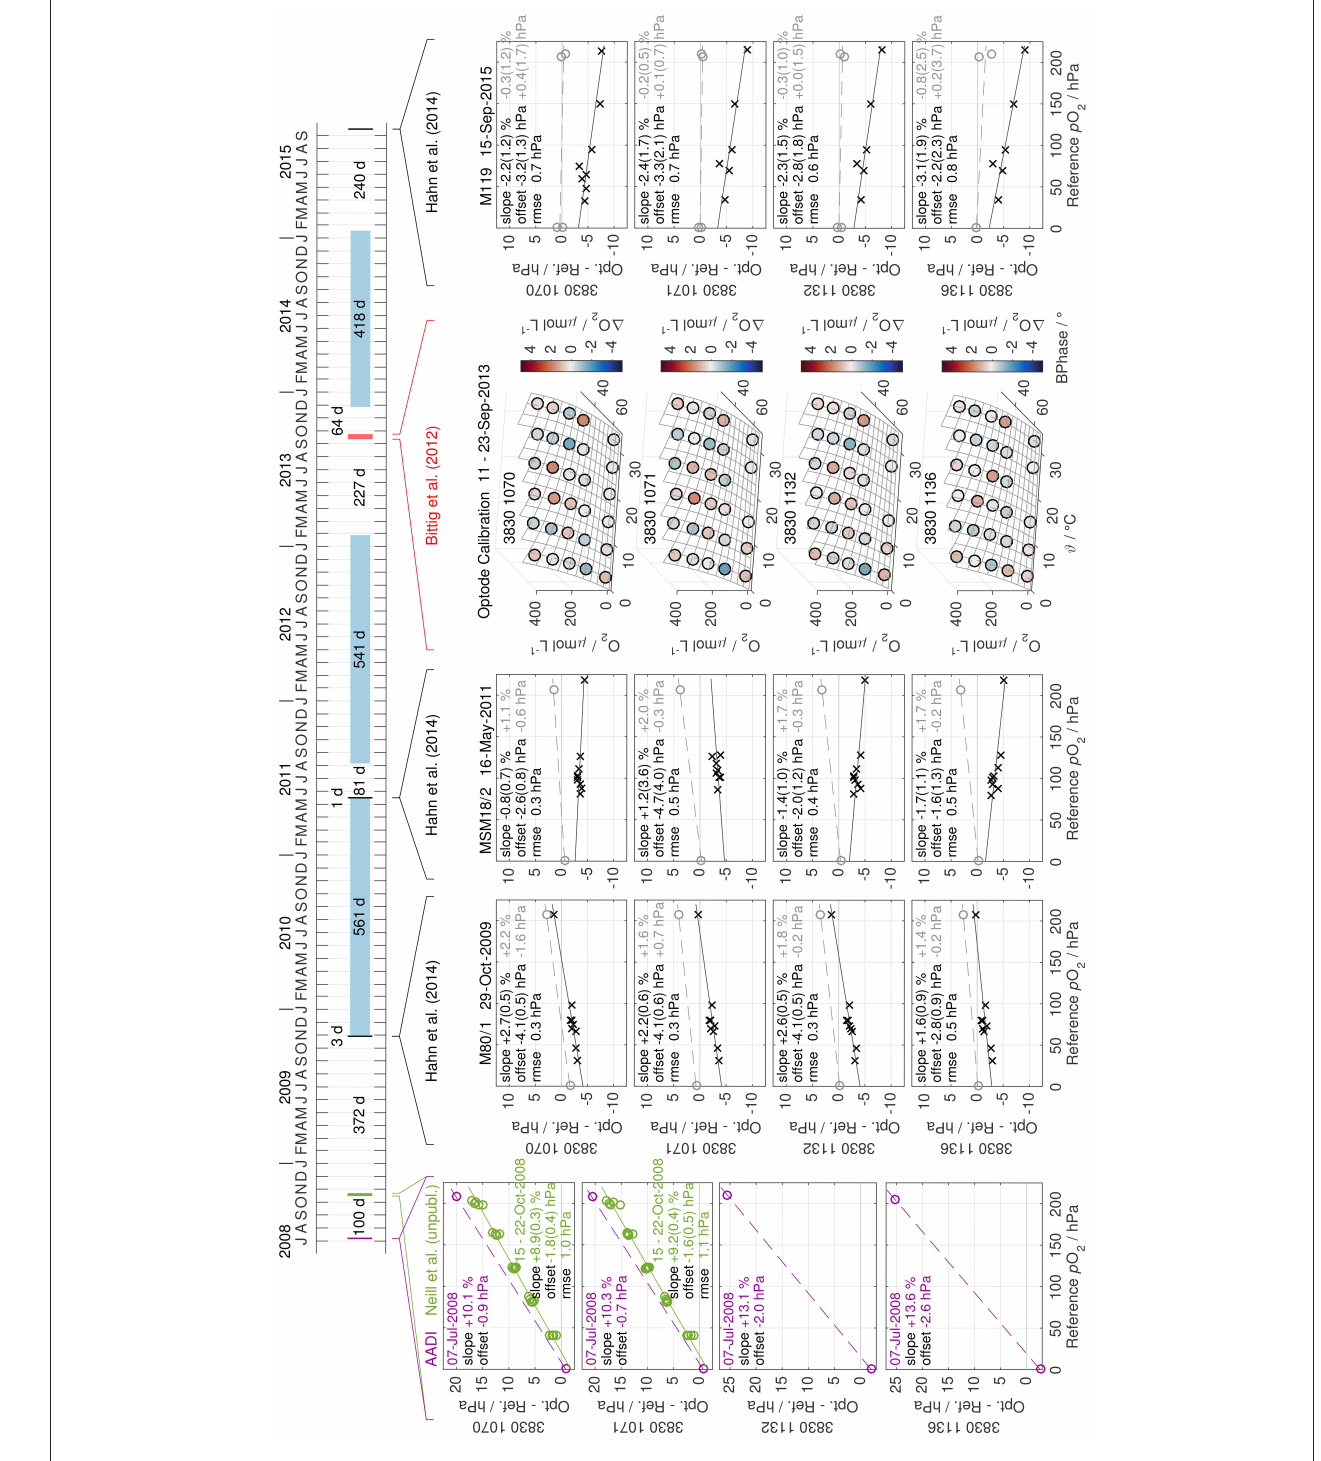
FIGURE 10 | Laboratory calibration and in-situ reference data from four Aanderaa 3830 optodes used on moorings in the Eastern Tropical North Atlantic. The timing of factory batch two-point calibration (purple), BCCR Bergen and GEOMAR Kiel laboratory calibrations (green and red bar, respectively), on-ship calibrations (two-point laboratory and in-situ CTD casts, black bars), and moored periods (blue patches) along with the time difference between events (in days) is given on top. Below, residuals of the GEOMAR laboratory calibration (September 2013) are shown in (O 2 , ϑ , ϕ )-space in the second column from right. The other four columns